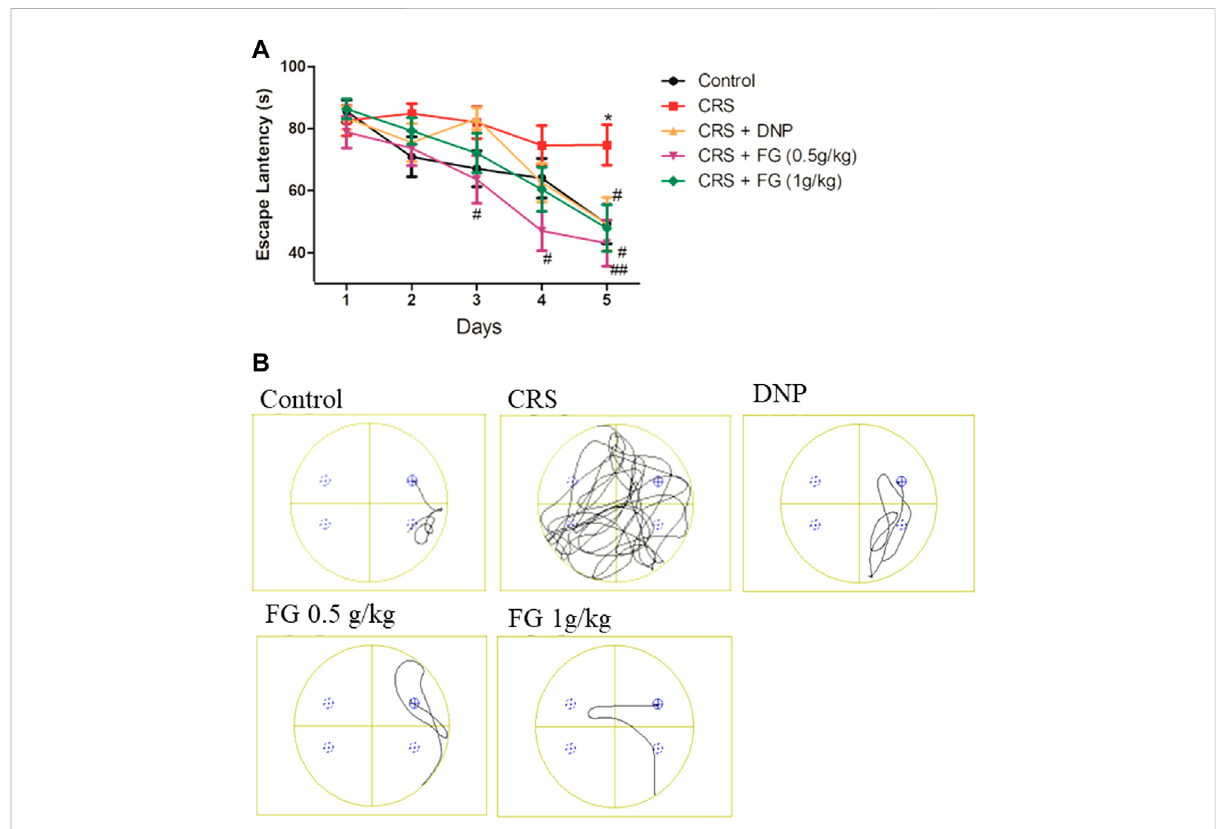
FIGURE 6 Effect of CRS, FG, and DNP on the MWMT of mice induced by CRS. Values represent the mean ± S.E.M. n = 9 ~ 12 mice/group. (A) Escape latency; (B) Swimming track example (* p < 0.05 compared with the control group; # p < 0.05, ## p < 0.01 compared with the CRS